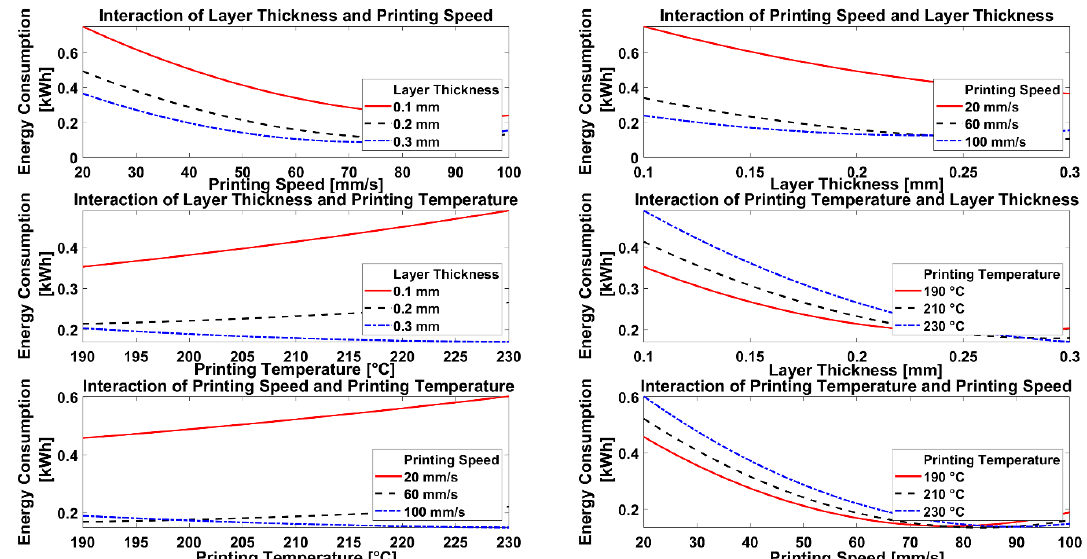
Figure 14. Effects of interaction of parameters on measured energy consumption. Figure 14. E ff ects of interaction of parameters on measured energy consumption.